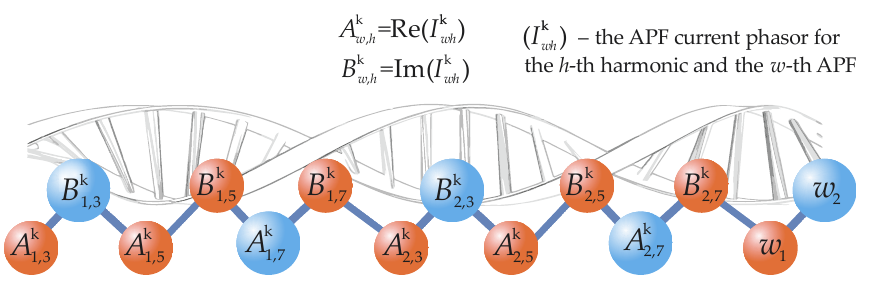
Figure 9. Sample chromosome structure for APF current optimization (see Equation (11)).